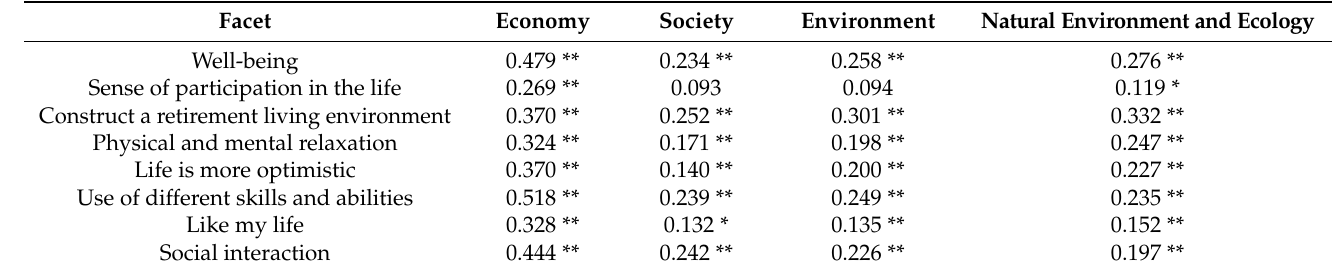
Table 3. Analysis of the influence of village economy, society, environment, natural environment, and ecological development on